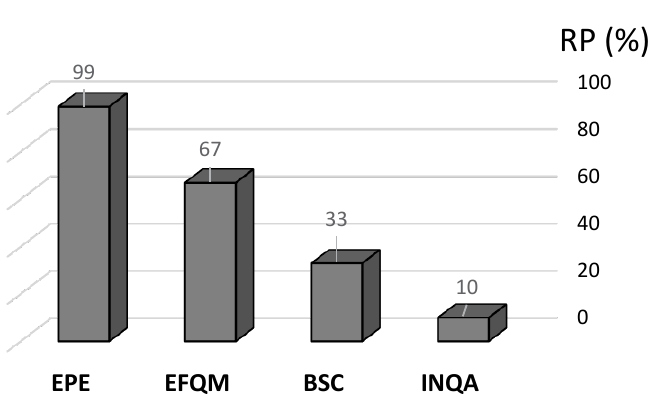
Figure 7. Ranking the EPE models according to the degree of proximity to the positive ideal solution and distance from the negative ideal solution in the TOPSIS method Abbreviations: INQA, Iran national quality award; BSC, balanced scoring card; EFQM,